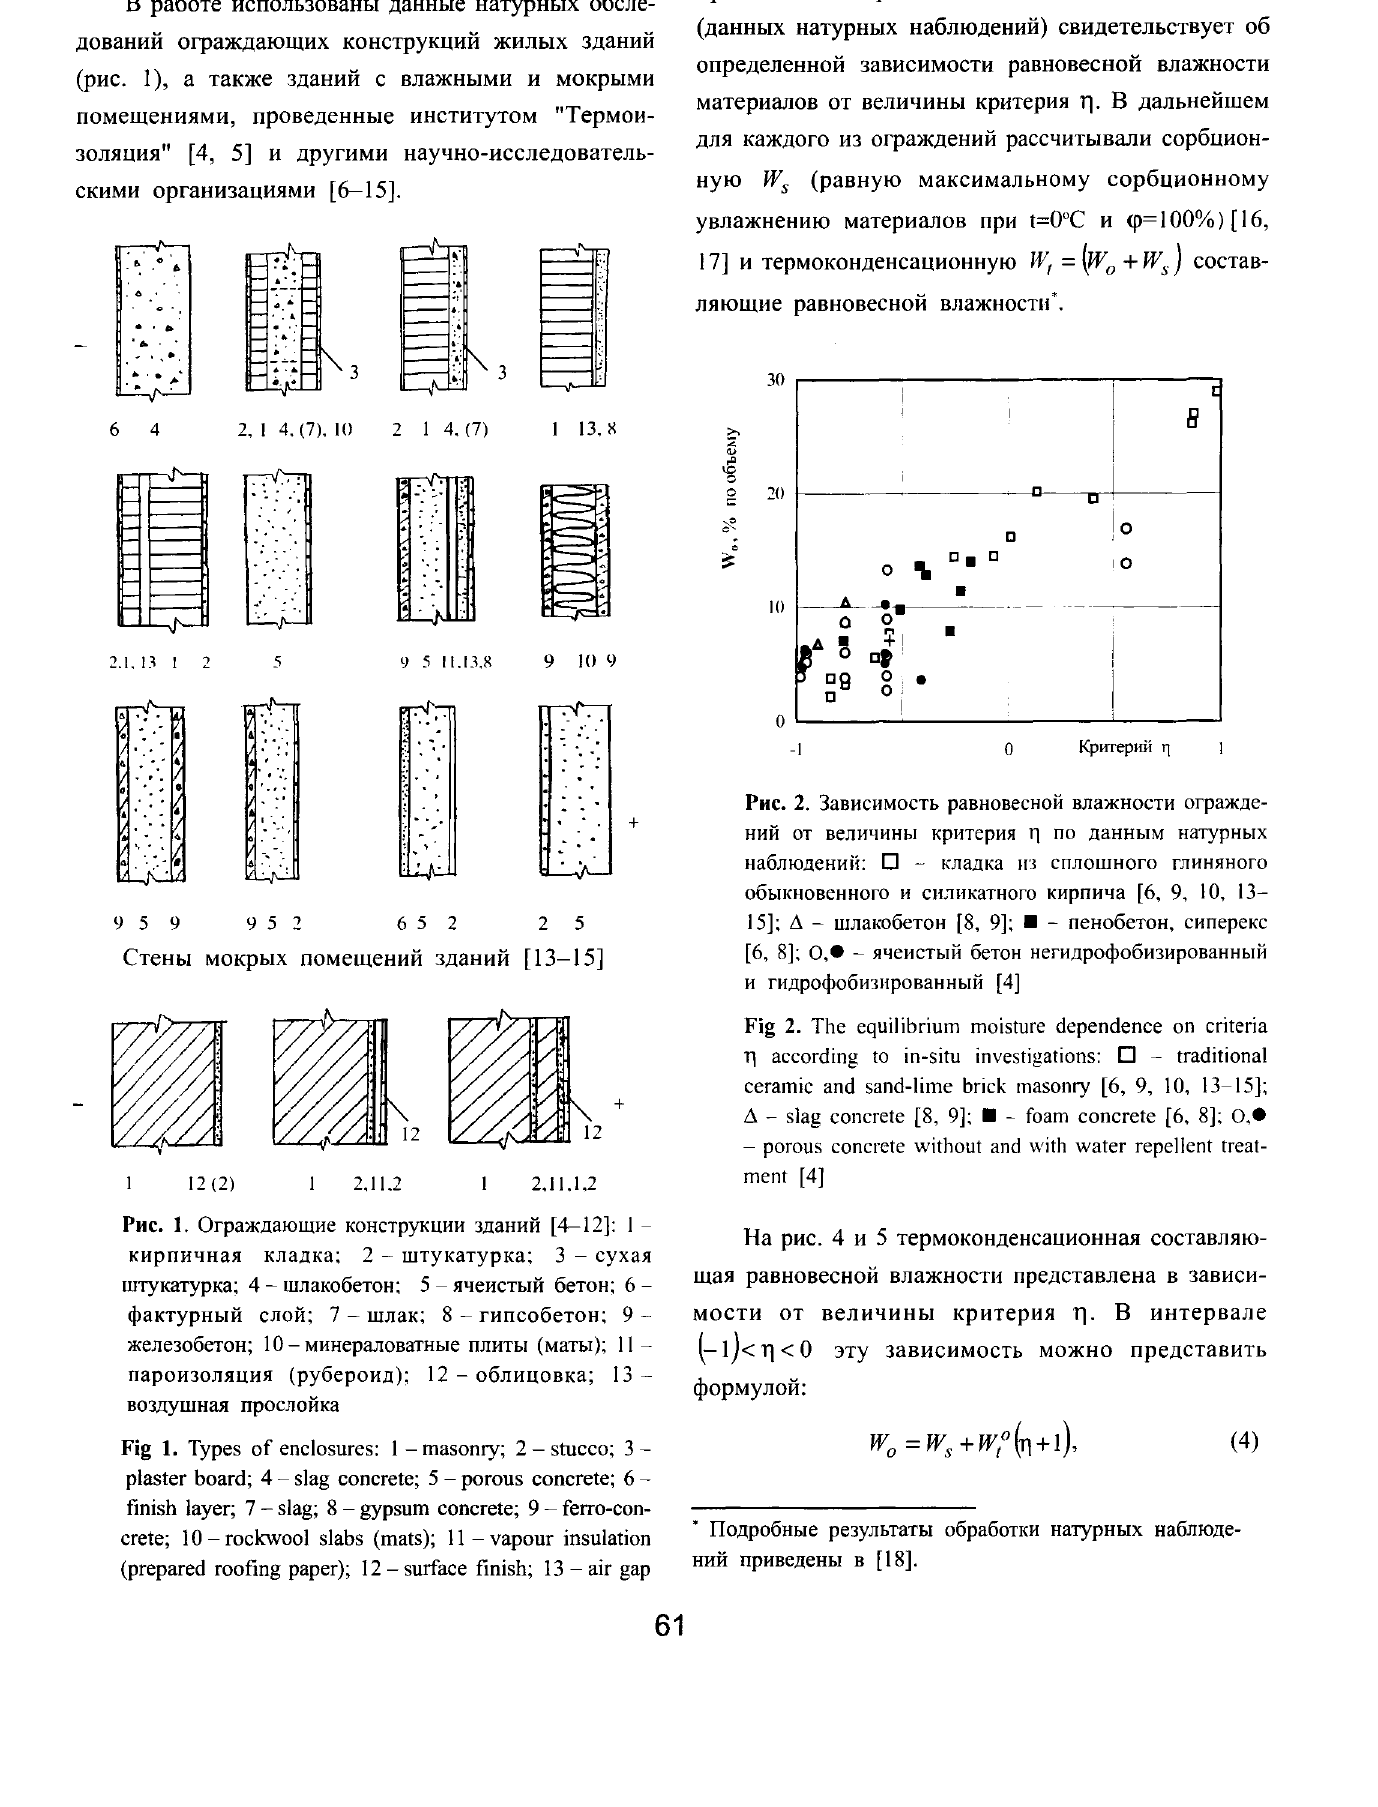
3.2. PeJyJILTaTbi onpe.a:eJieuus pasuouecuoii BJia~­ uocTu orpa~euuii no naTypuLIM ua6Jiro.a:ennHM PeJynbTaTbi o6pa6oTKu HaTypHhlX Ha6mo.neHuii npuue.neHbi Ha puc. 2 u 3. Pacnono)J(eHue ToqeK